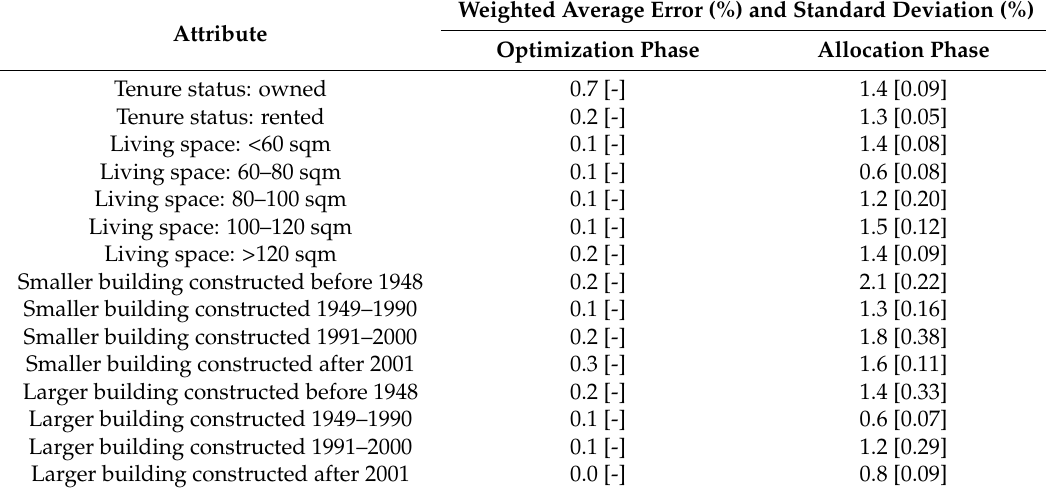
Table 3. Weighted average error and standard deviation for dwelling attributes.